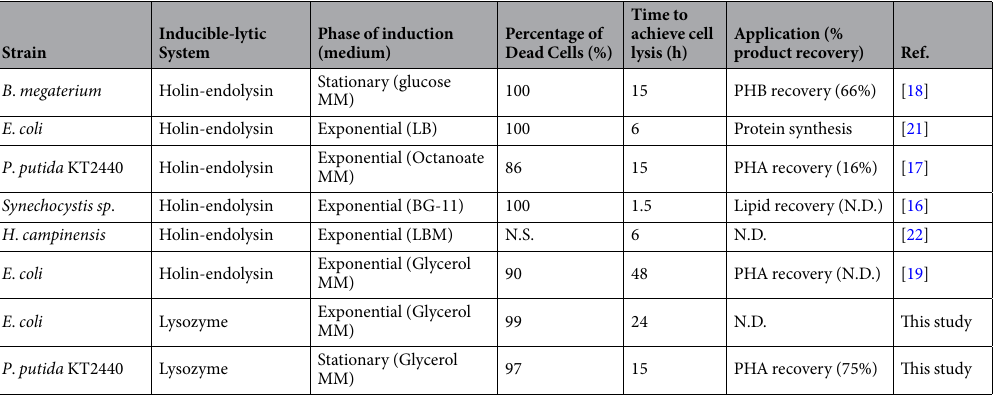
Table 2. Overview of various cell lysis systems and their use in biotechnological applications. N.S. Not shown, N.T. Not determined, M.M. Minimal medium, LB. Luria Bertani medium, BG. Rich